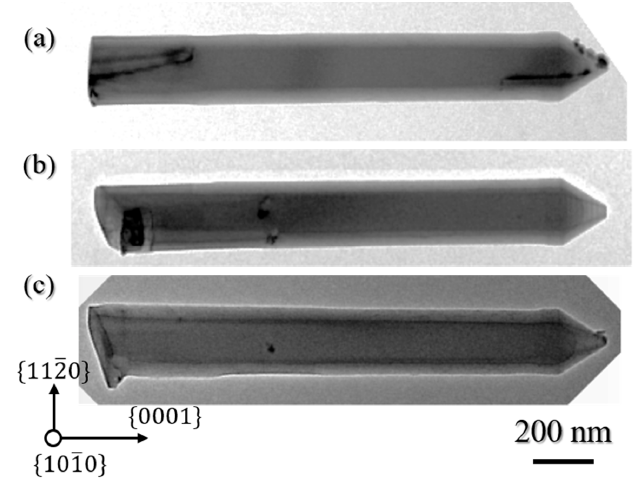
Figure 6. ( a – c ) TEM images of three different AlN faceted nanorods acquired along the [ 101(cid:3364)0 ] zone axis. The left and right hand-side of each image corresponds to the bottom and the top of the nanorod, respectively.